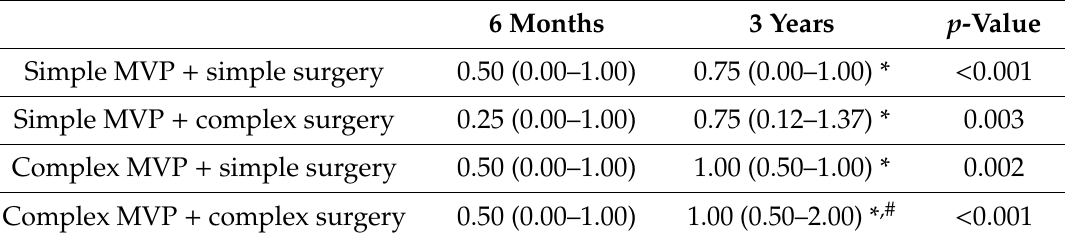
Table 4. Six-months and 3-years residual mitral regurgitation according to MVP anatomy and surgery technique reported as median (25th–75th